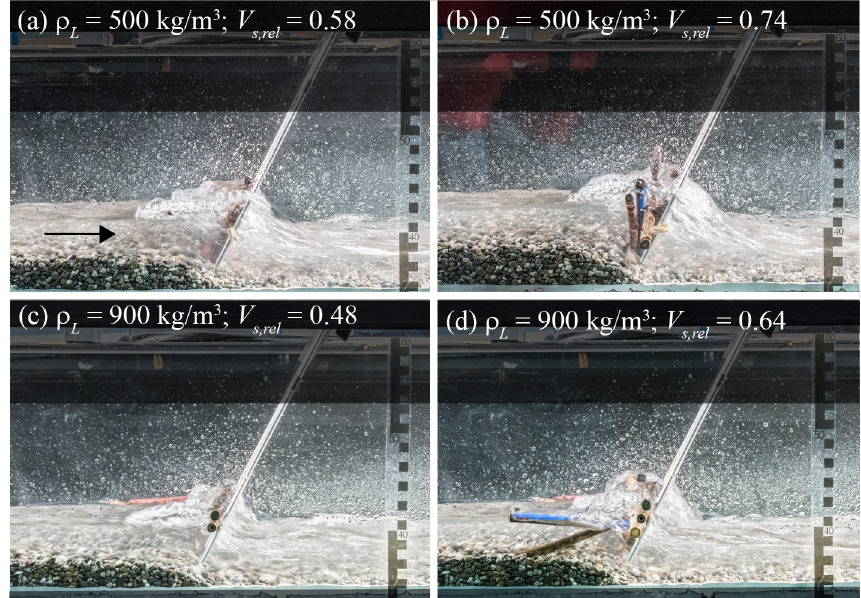
Figure 4. LW accumulation and bedload deposition at the inclined bar screen for ( a ) test V1b ( ρ L = 500 kg/m 3 ) with V s , rel = 0.58 and ( b ) V s , rel = 0.74, compared to ( c ) test V4 ( ρ L = 900 kg/m 3 ) with V s , rel = 0.48 and ( d ) V s , rel =